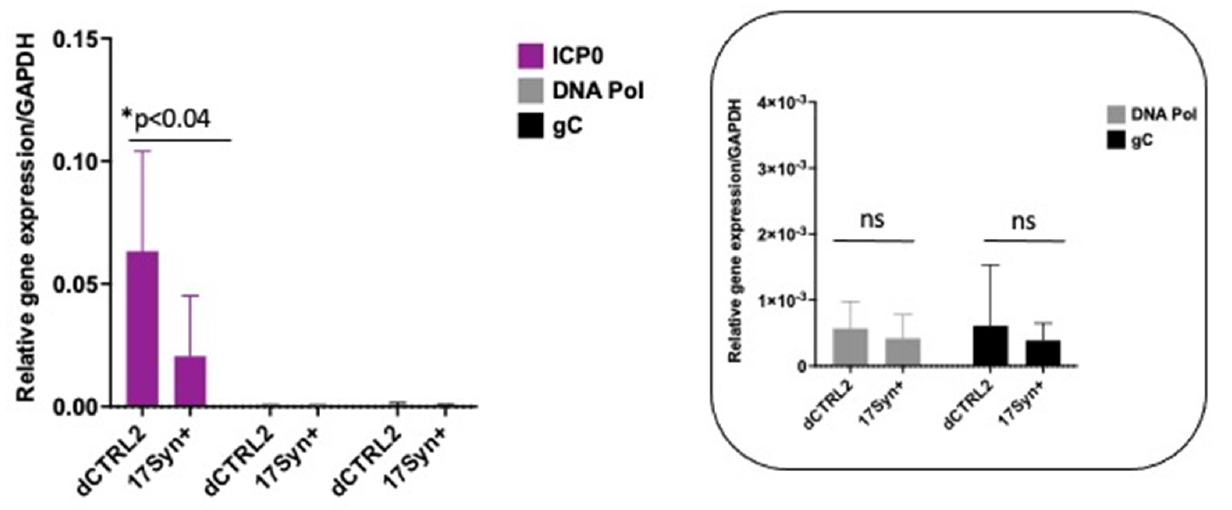
Figure 4. ICP0 expression was significantly higher in the ∆ CTRL2-infected rabbits during latency, but early and late gene expression was consistent between the two virally infected cohorts. Rabbit TG were isolated and RNA was extracted as indicated in the methods section, and subsequently used for qRT-PCR to assess gene expression during latency for the wt and recombinant viruses. Relative values for ICP0, DNA pol and gC were normalized to rabbit GAPDH and are presented as normalized ratios for gene expression ( inset ). ICP0 expression was significantly higher than DNA pol and gC. The y-axis scale was adjusted to account for the increase in ICP0 expression. One-way ANOVA of independent samples was used to determine the statistical significance between the mutant and wt samples ( n = 6). Data presented here are consistent with previous reports of the mouse model. There was a significant increase in ICP0 expression in the ∆ CTRL2-infected rabbits compared to wt-infected animals at latency. * indicates a significant reduction in luciferase expression between the LTE and LTE/CTCF